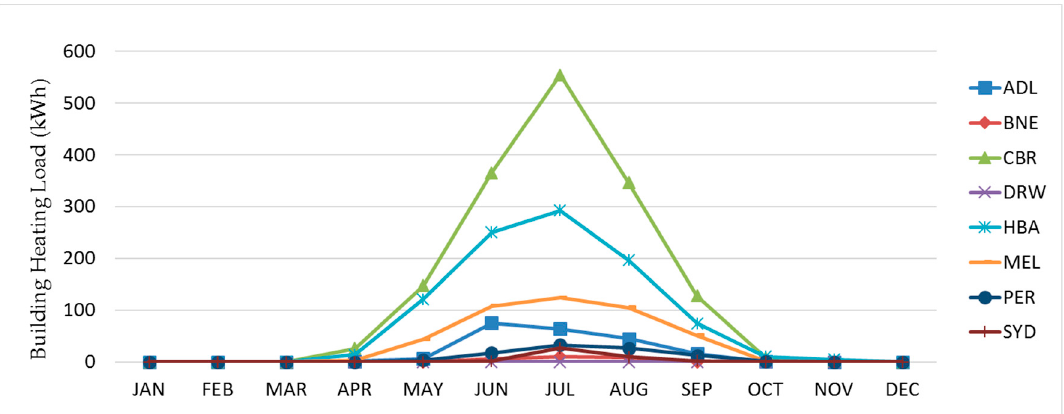
Figure 11. Monthly building heating load.